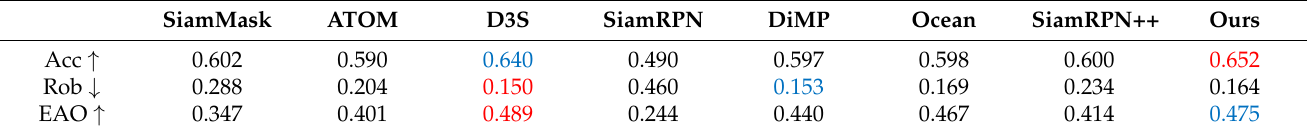
Table 2. Comparison of properties on the public VOT2018 dataset with regards to EAO, robustness, and accuracy. Red and blue represent 1st and 2nd, respectively.